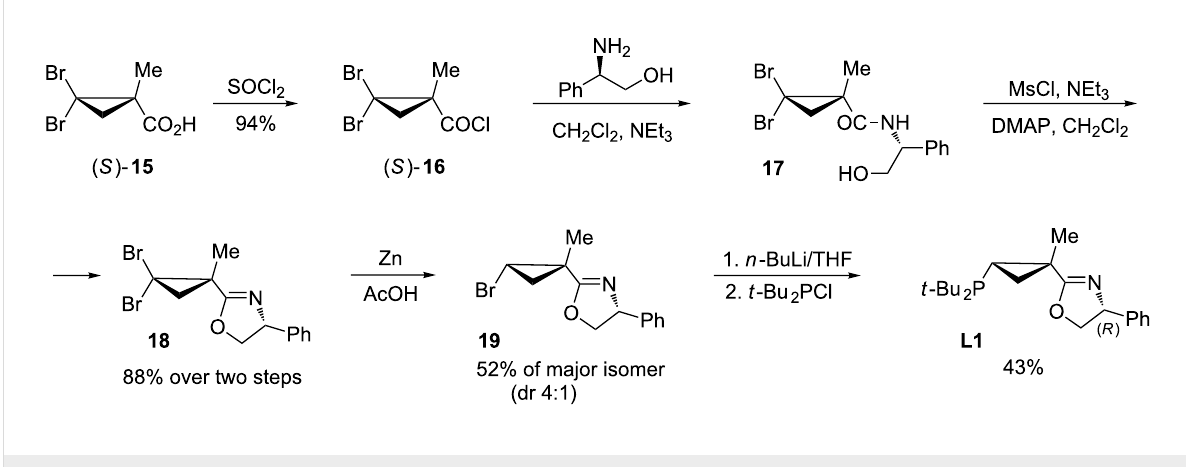
Scheme 3: Synthetic scheme for preparation of PHOX ligands with chiral cyclopropyl backbone.